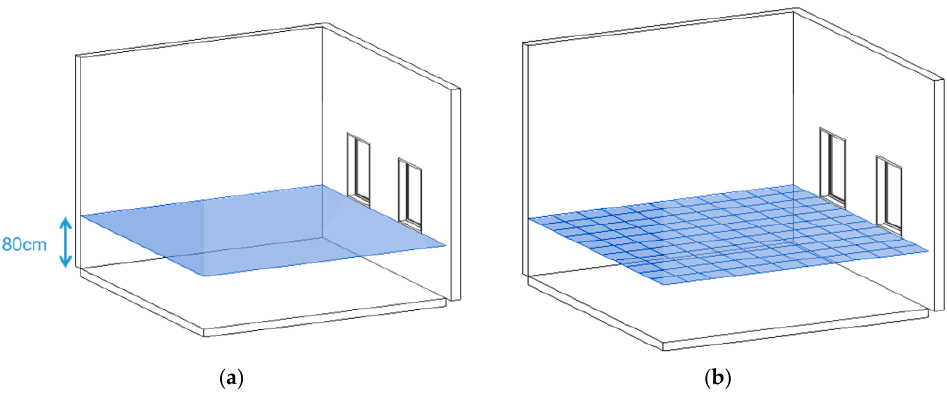
Figure 4. ( a ) Diagram of environmental data body-feeling range; ( b ) diagram of cutting plane grid.